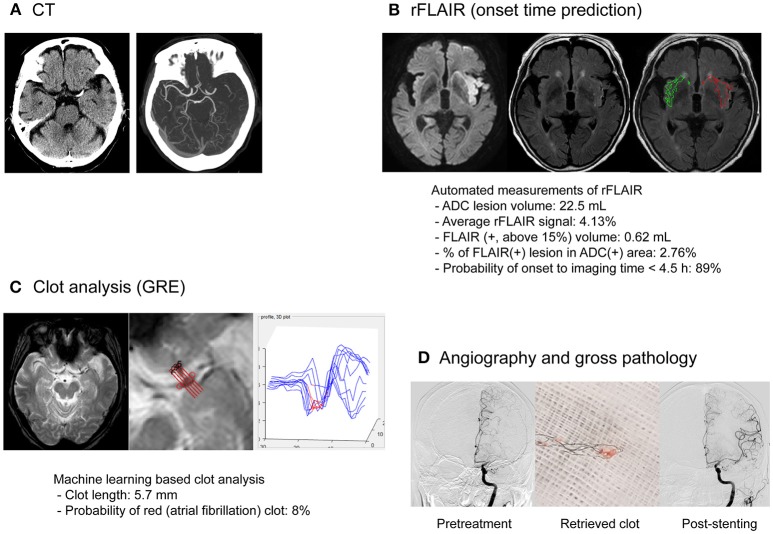
MRI-based endovascular treatment of a stroke patient with unclear symptom onset time and atherosclerotic occlusion of the middle cerebral artery. An 81-year-old male presented with right-sided weakness and global aphasia, with an unclear onset time. (A) On the CT image, left MCA occlusion was documented with an ASPECTS of 8. The patient underwent multimodal MRI using a fast (9 min) MRI protocol. (B) Minimal signal change was observed on FLAIR imaging and the probability of stroke onset within 4.5 h, based on relative FLAIR signal analysis, was high. (C) Clot analysis using GRE imaging and machine-learning techniques showed a low possibility of atrial fibrillation as cause of the clot. (D) Whitish clots were retrieved during endovascular treatment. Successful recanalization (mTICI grade 2b) was achieved with rescue stenting after repetitive reocclusion with a stentriever. His modified Rankin score at the 90th day was 1. CT, computed tomography; MCA, middle cerebral artery, ASPECTS, Alberta Stroke Program Early CT Score; ADC, apparent diffusion coefficient; FLAIR, fluid attenuation inversion recovery; GRE, gradient echo; mTICI, modified treatment in cerebral ischemia.